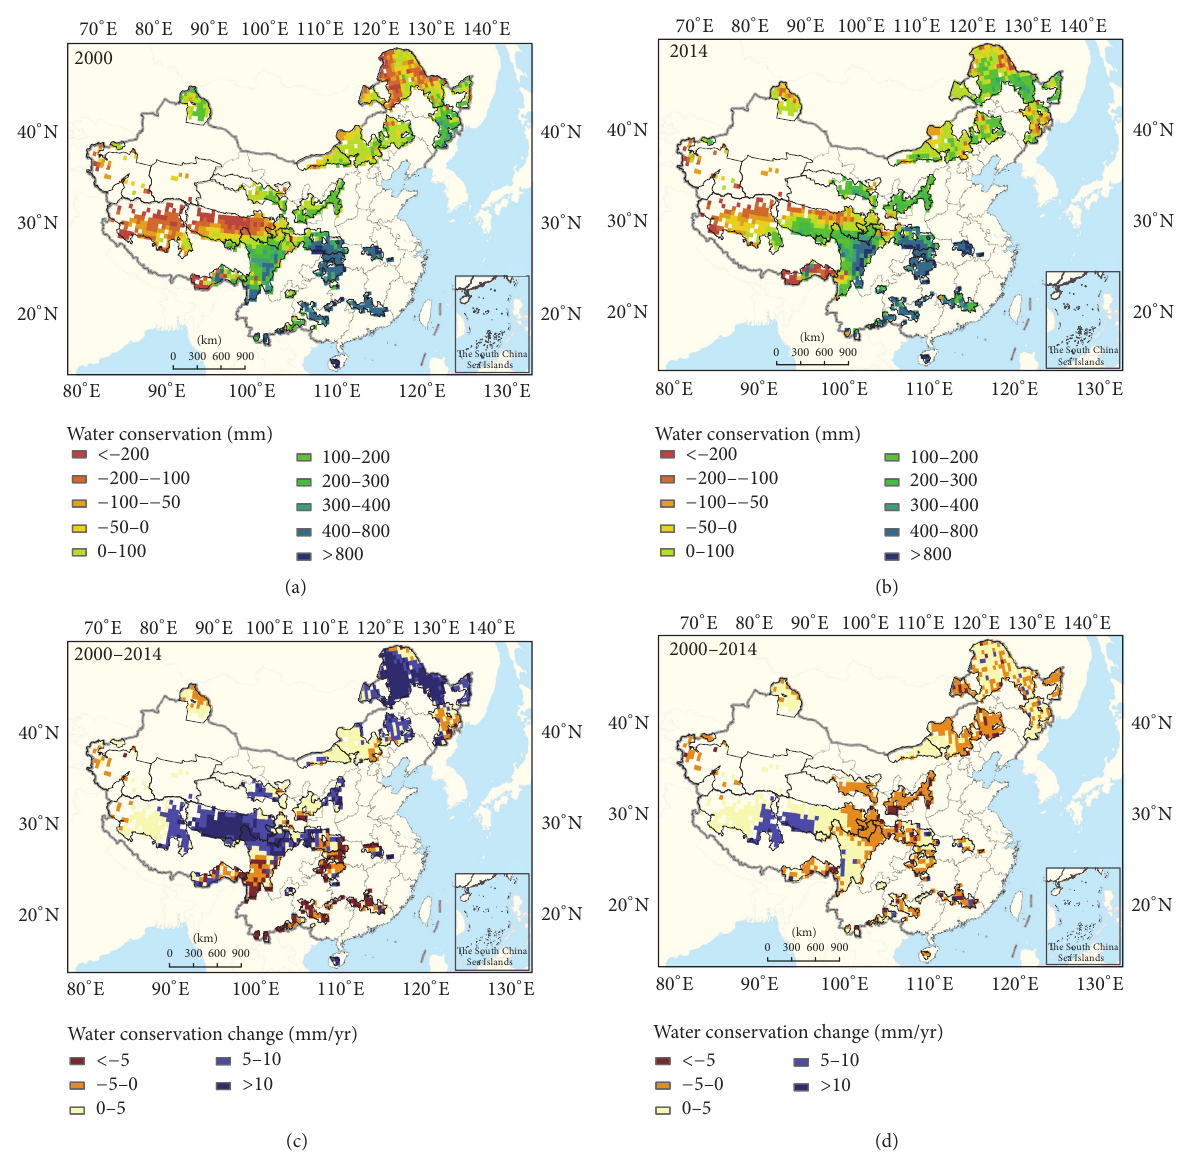
Figure 7: Spatial distribution and change of water conservation in NKEFZ ((a) WR of observation in the NKEFZ of 2000; (b) WR of observation in the NKEFZ of 2014; (c) WR change of observation in the NKEFZ; (d) WR change of simulation in the NKEFZ).